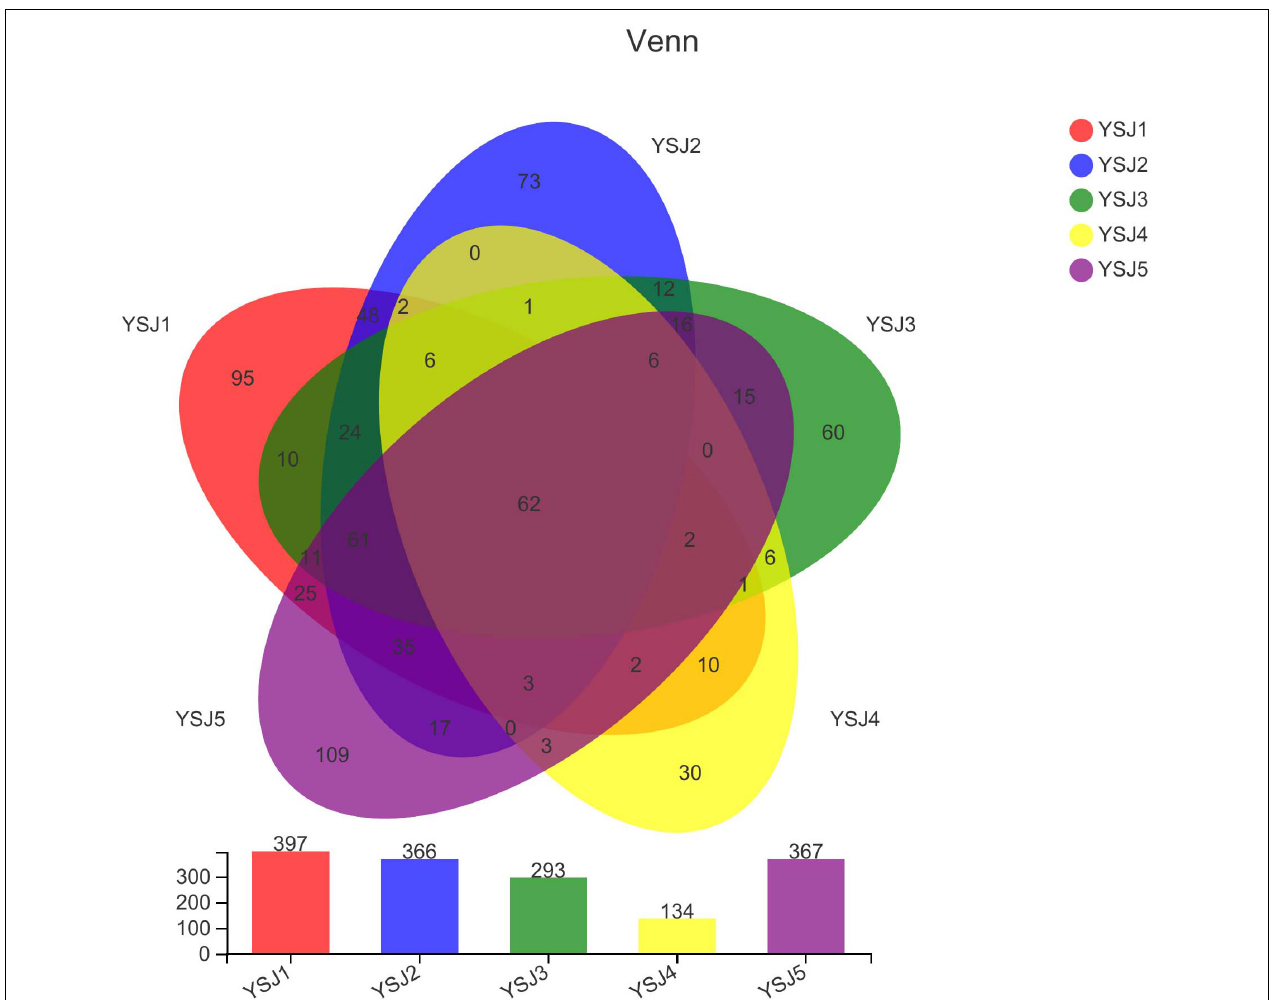
FIGURE 2 | Venn diagram of OTUs. Different groups are represented by different colors, and numbers in overlapping portions represent the number of species common in all groups.